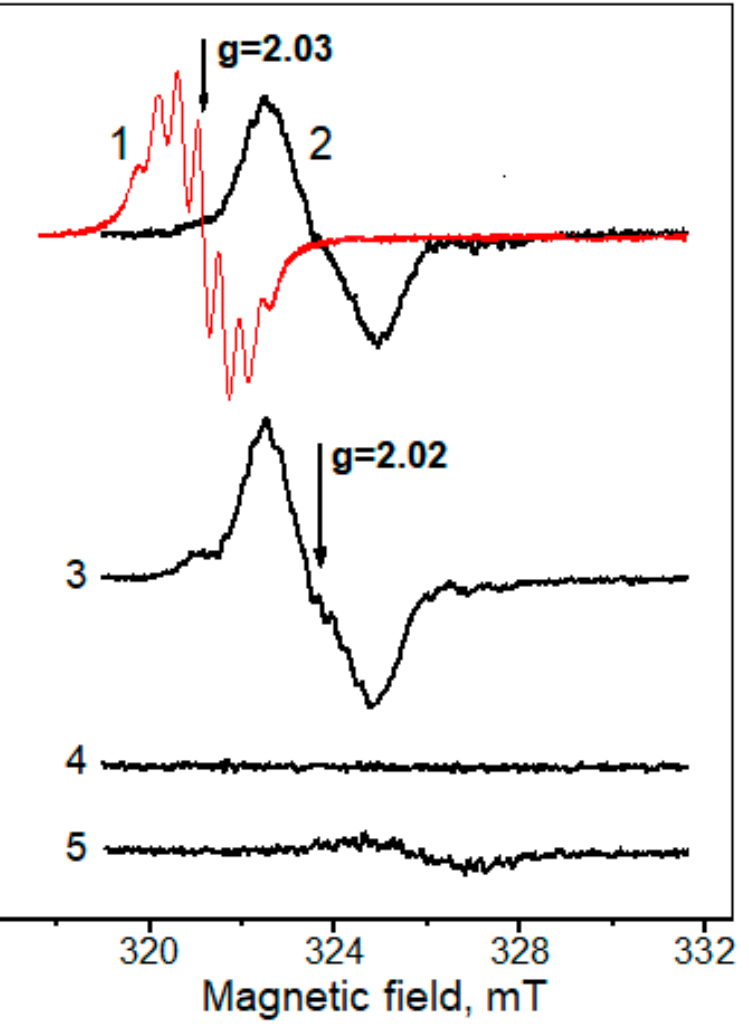
Figure 7. Formation of the new type of DNICs bound with lysine and modified with MG. (1)—reaction mixture: 0.2 M PBS (pH 8.0), 160 mM MG and 1 mM DNIC-PO 4 − ; (2)—(1) + 160 mM lysine; (3)—the same as (2), but instead of DNIC-PO 4 − , 0.4 mM FeSO 4 and 8 mM PAPA NONOate were added. (4)—160 mM lysine + 0.4 mM FeSO4 + 8 mM PAPA NONOate. (5)—the same as (2) + 1 mM bathophenanthroline added after 5 min. EPR spectra were recorded 2.5 min after mixing the components at nitrogen purging. The amplitude of the high-frequency modulation—0.1 mT.